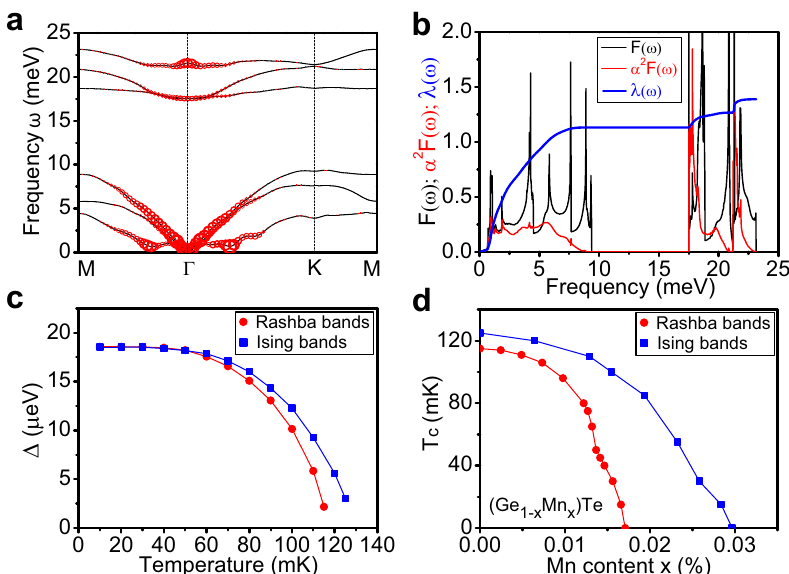
Fig. 2 The superconductivity of 0.1-hole-doped GeTe monolayer without/with Mn dopants. a Phonon spectra with the magnitude of EPC strength λ q v being drawn proportional to the size of red circles. b The plots of phonon DOS F ( ω ), Eliashberg spectral function α 2 F ( ω ), and cumulative frequency-dependent EPC strength λ ( ω ). c The temperature-dependent superconducting gap Δ and ( d ) the x -dependent translation temperature T c of the Rashba bands (red dots) and the Ising bands (blue squares) calculated on 600 × 600 × 1 k -points sampling in fi rst